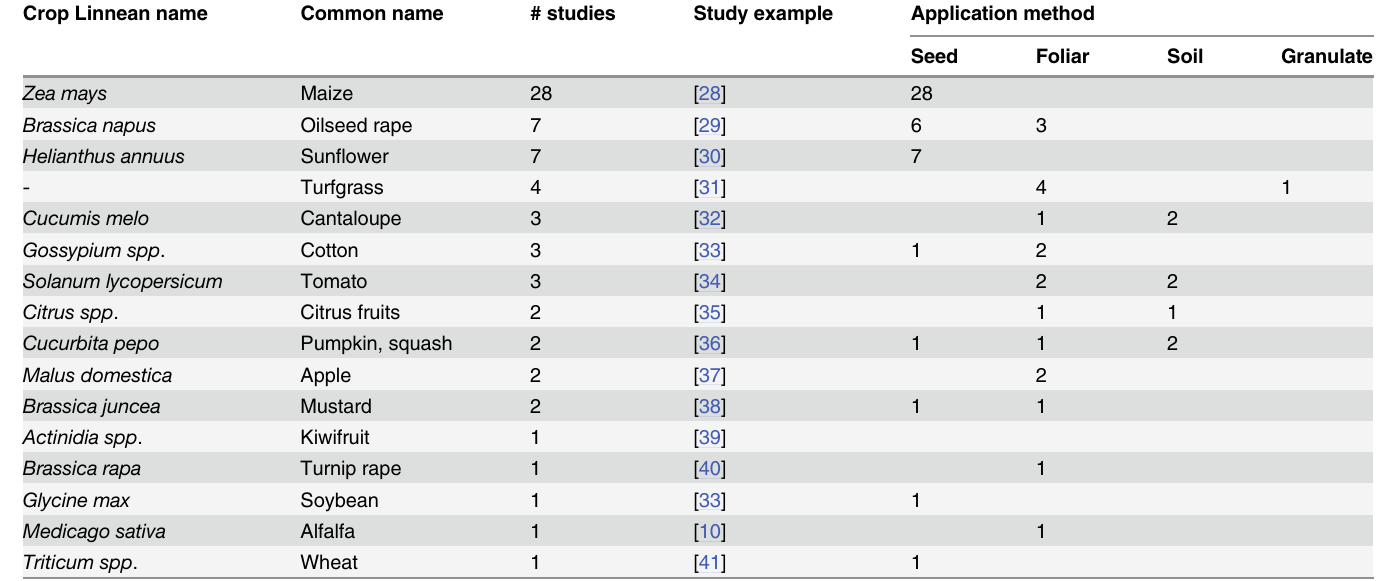
Table 1. Total number of studies on neonicotinoids and bees in different crops, study examples for each crop, and number of studies for each method of application in each crop ( ‘ Seed ’ = seed treatment application, ‘ Foliar ’ = foliar spray application, ‘ Soil ’ = furrow, drench or drip irrigation application, Granulate = granulate application).